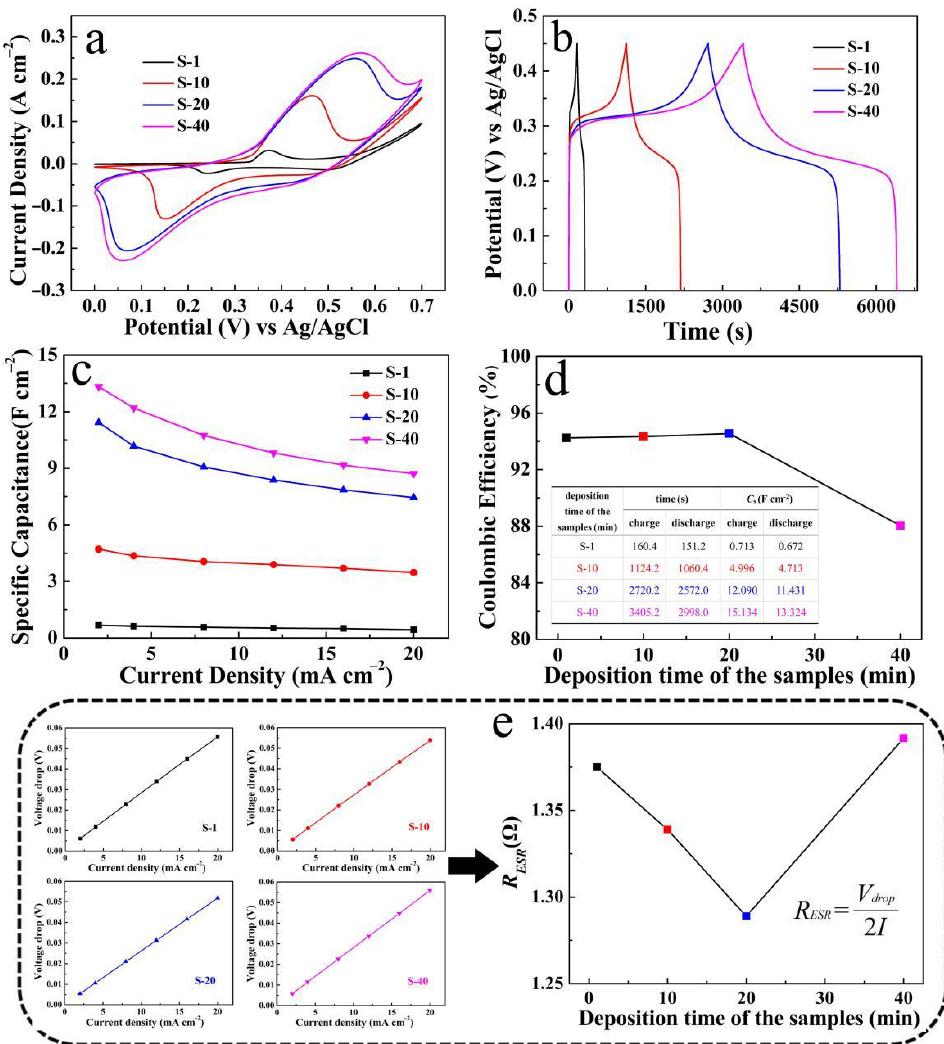
Figure 8. ( a ) CV curves, ( b ) GCD curves, ( c ) specific capacitances at different current densities, ( d ) coulombic efficiency, and ( e ) average R ESR of the Cu(OH) 2 /Ni 3 S 2 composite grown on copper foam with different potentiostatic deposition time of Ni 3 S 2 .